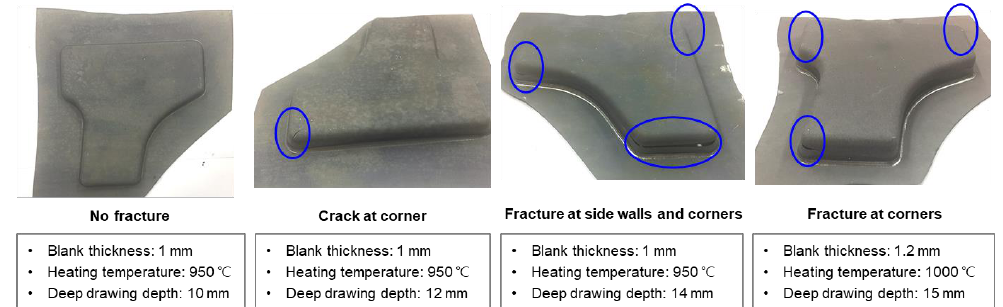
Figure 5. Shape of formed T-type specimen according to sheet blank thickness and heating temperature condition.